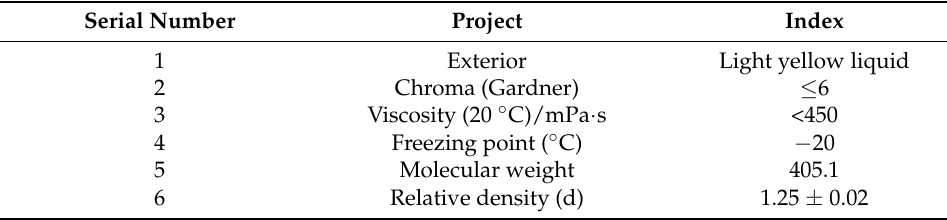
Table 4. Physicochemical properties of